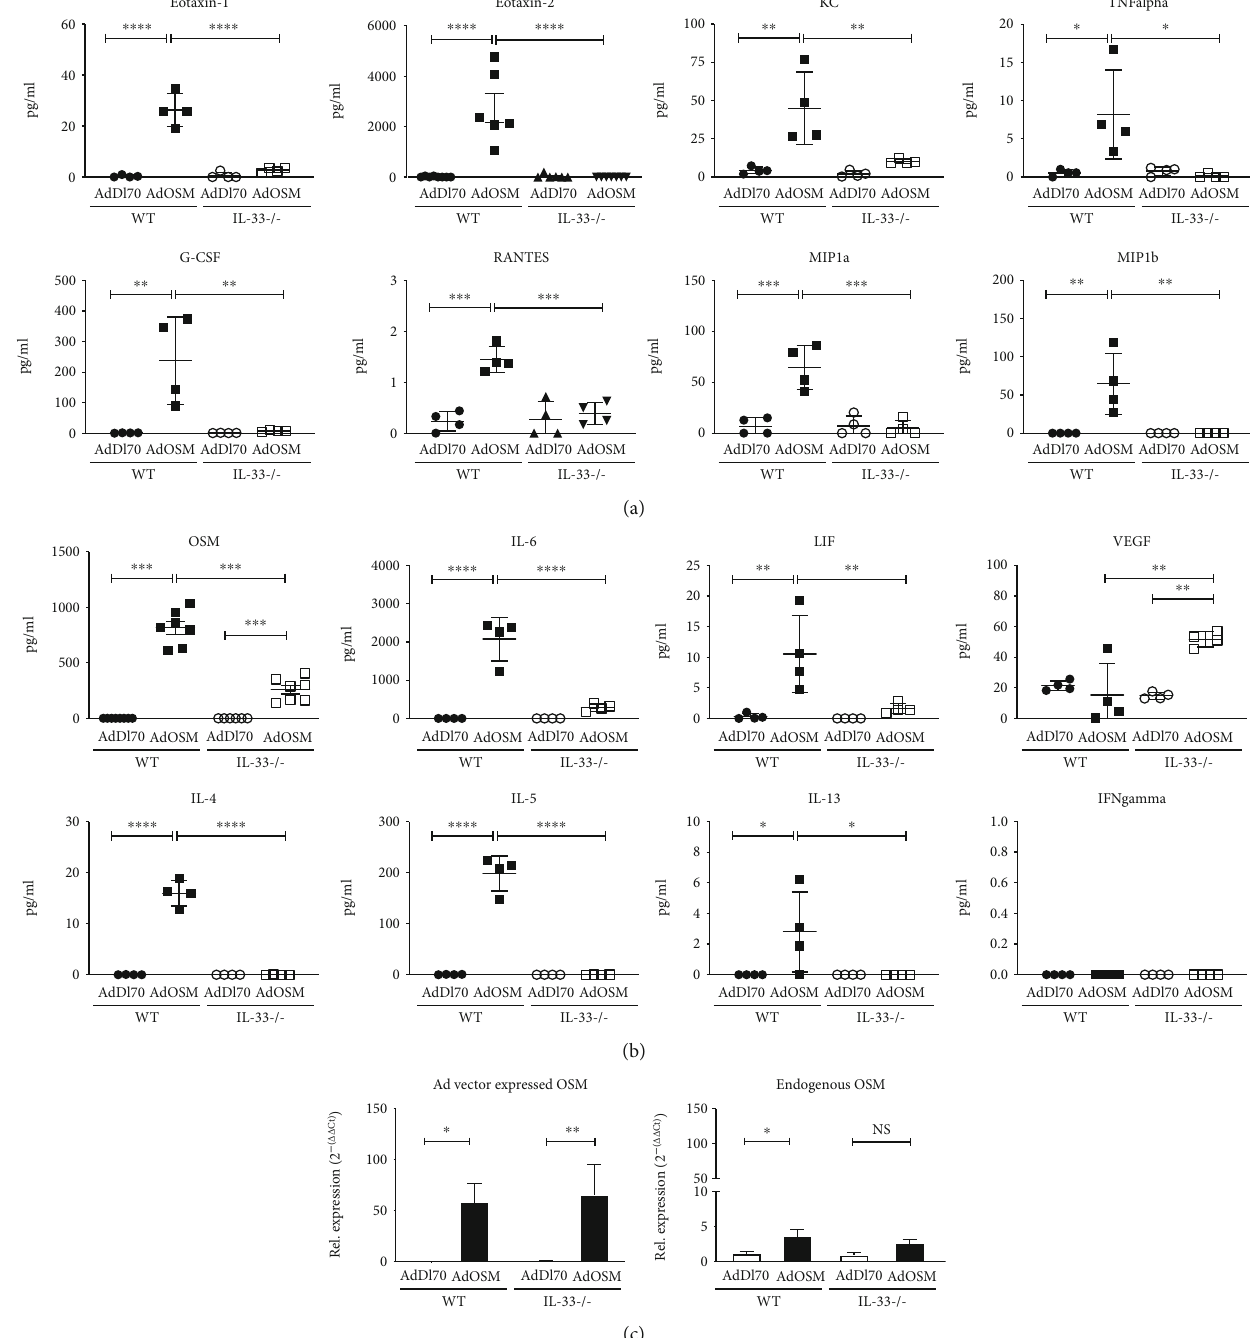
Figure 4: In fl ammatory cytokine and Th2 cytokine induction by AdOSM is markedly attenuated in IL-33-/- (KO) mice. C57Bl/6 wild-type (WT) or IL-33 knockout mice were endotracheally administered AdDl70 (control) or AdOSM, sacri fi ced at day 7, and collected bronchoalveolar lavage fl uid analyzed by ELISA for in fl ammatory cytokines/chemokines, Th1/Th2 cytokines, IL-6, and VEGF. (a) Detection of chemokines for eosinophils (eotaxin-1 and eotaxin-2) and neutrophils (KC) as well as other cytokines including TNFalpha, G-CSF, RANTES, or macrophage (MIP1a/MIP1b) in BALF of C57Bl/6 wild-type and IL-33-/- mice. (b) Detection of OSM, interleukin- (IL-) 6, leukemia inhibitory factor (LIF), VEGF, or Th2 (IL-4, IL-5, and IL-13) or Th1 (IFN γ ) cytokines in BALF of C57Bl/6 wild-type and IL-33-/- mice. (c) Endogenous (left panel) or adenoviral-derived (right panel) expression of OSM mRNA was examined by quantitative real-time PCR analysis of whole lung tissue from C57Bl/6 wild-type and IL-33-/- mice. Closed circles: WT/AdDl70; closed squares: WT/AdOSM; open circles: IL-33KO/AdDl70; open squares: IL-33KO/AdOSM; Rel. expression: relative expression. Represents one of two separate experiments. ∗ p < : 05 , ∗∗ p < : 01 , ∗∗∗ p < : 001 , and ∗∗∗∗ p < : 0001 . N = 4/group